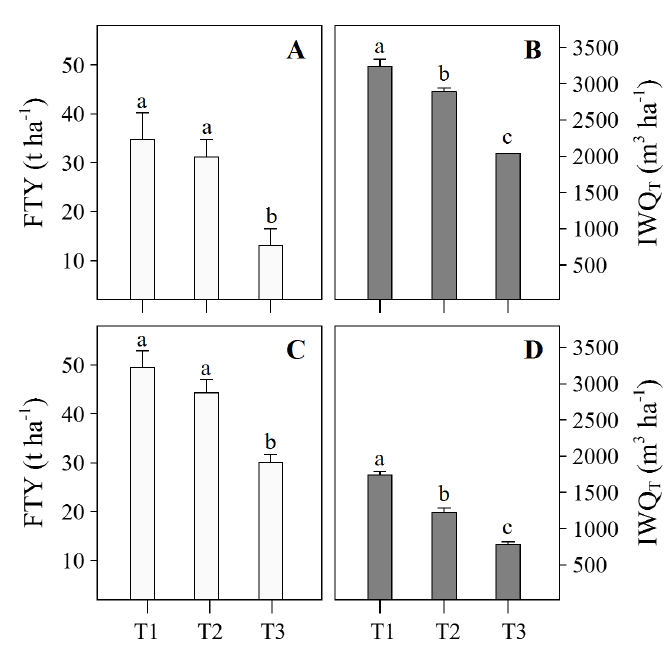
Figure 6. Average value ( ± standard error) of fresh tuber yield (FTY) and total irrigated water quantity (IWQ T ) in the first ( A , B ) and second ( C , D ) experiment. The different letters in each subfigure indicate significant differences ( p < 0.05) between treatments (T1: Control or full irrigation, T2: CWSI < 0.4, and T3: CWSI < 0.7) detected by LSD test. CWSI—Crop water stress